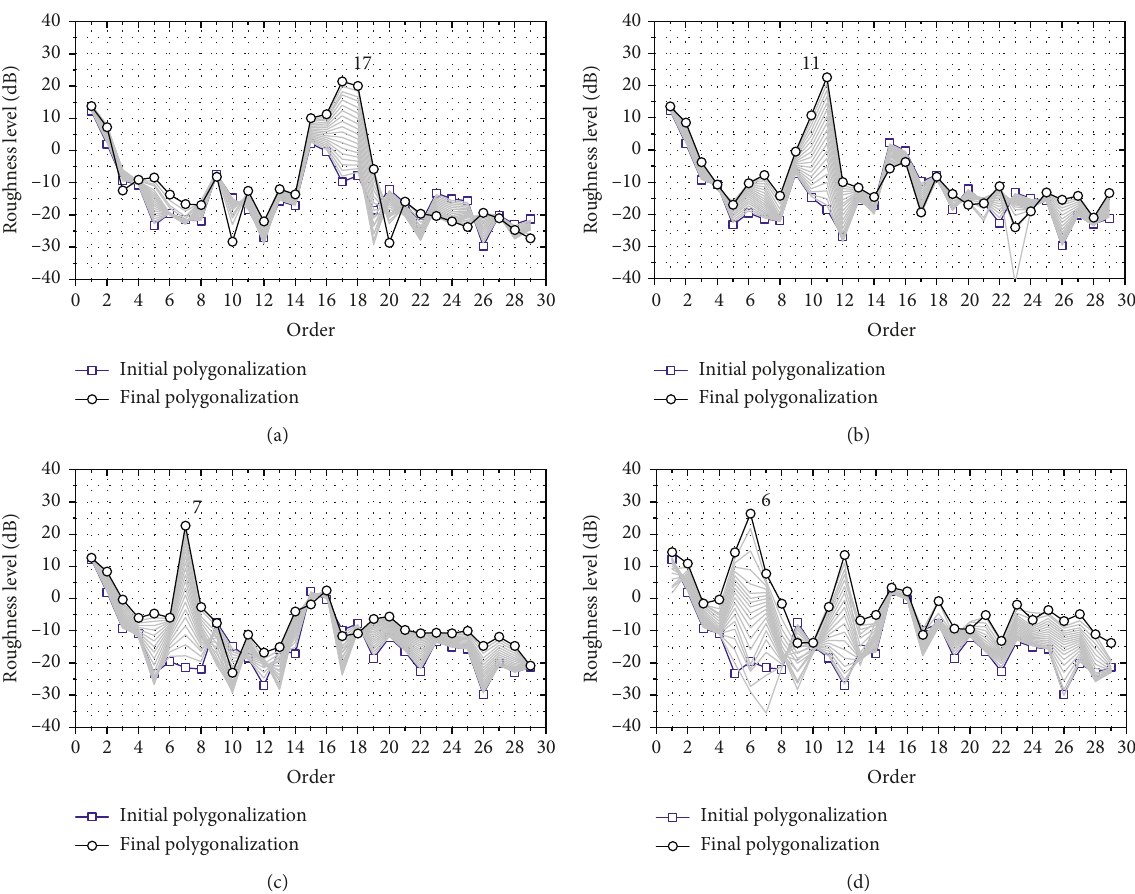
Figure 21: Evolution of wheel polygonalization at different vehicle speeds (after 22,000km): (a) 30km/h; (b) 50km/h; (c) 75km/h; (d) 90km/h.